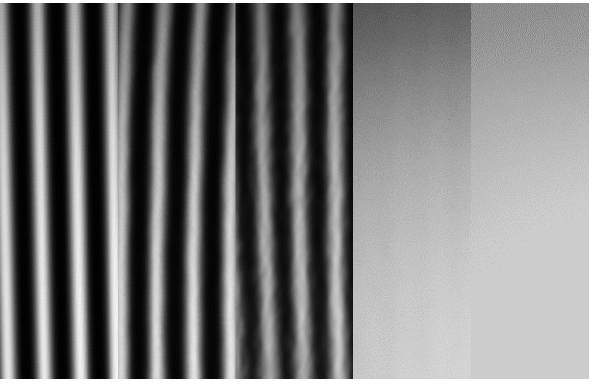
Figure 4. Image of a reflected pattern for five different surfaces ranging from high to low gloss for a pattern on the screen with spa- tial frequency k cam = 1mm − 1 . Note the modulation change from left (high gloss, c = 3 . 8) to right (low gloss, c = 2 . 5), where the pattern is almost invisible.